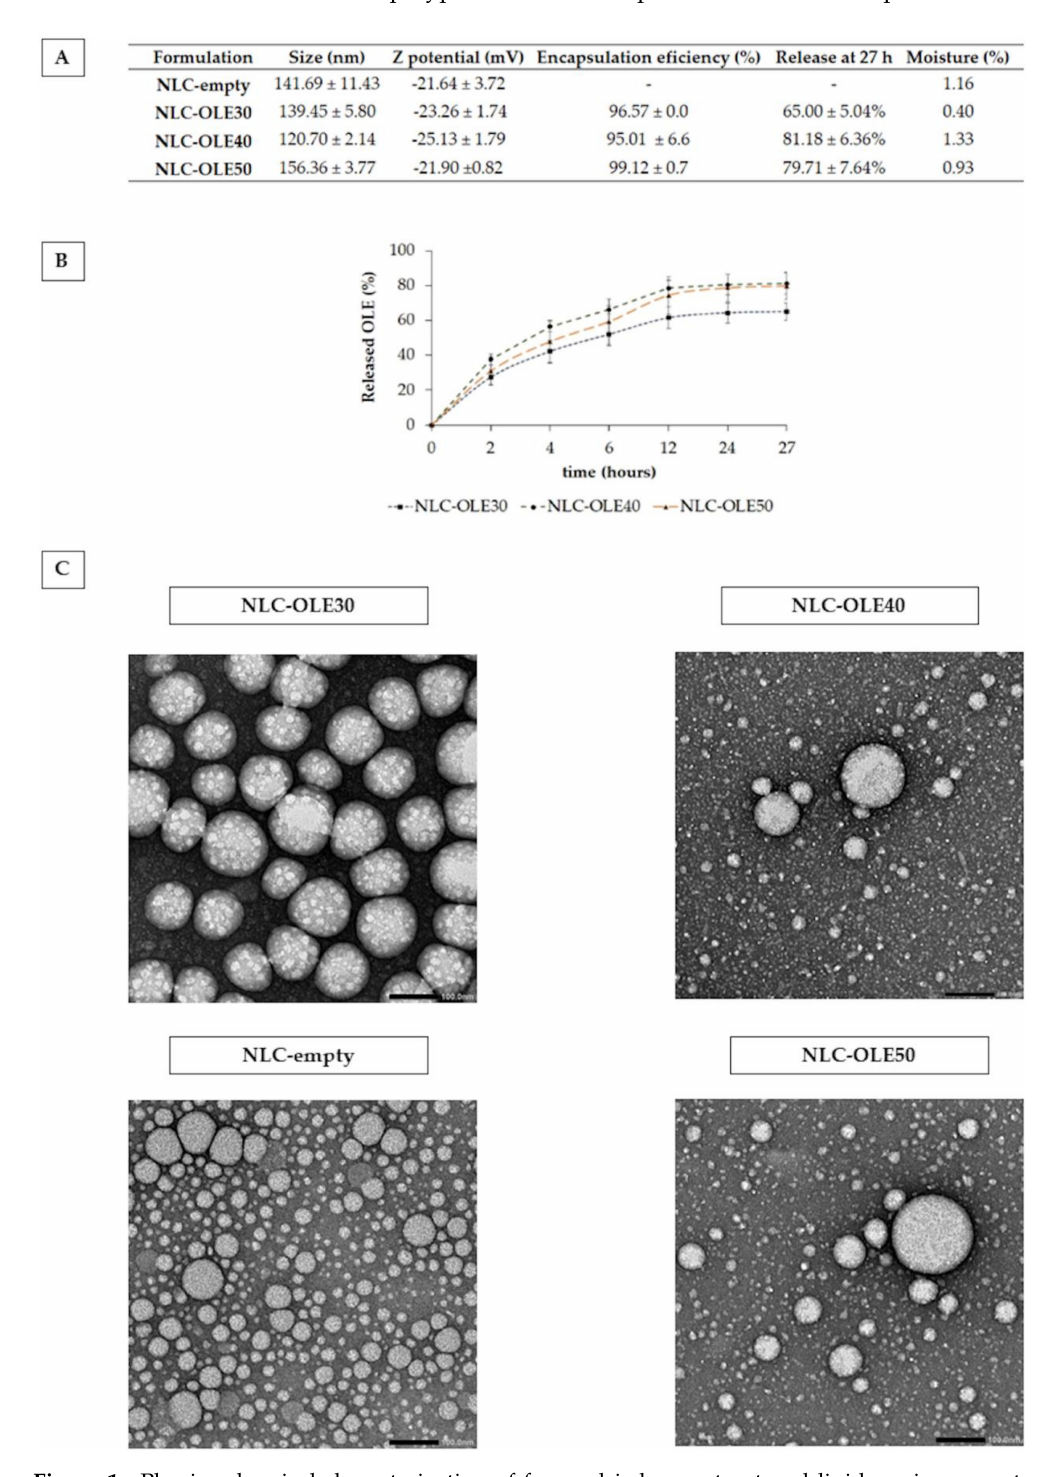
Figure 1. Physico-chemical characterization of freeze-dried nanostructured lipid carriers: empty (NLC-empty) and oleuropein (OLE) loaded, with a targeted OLE loading of 30% (NLC-OLE30), 40% (NLC-OLE40) and 50% (NLC-OLE50) ( w / w ). ( A ) Particle size, Z potential, encapsulation e ffi ciency, total released OLE and moisture content of NLCs. ( B ) In vitro release of OLE from developed NLCs. ( C ) TEM micrographs of OLE-loaded and empty nanoparticles. The scale bar indicates 100